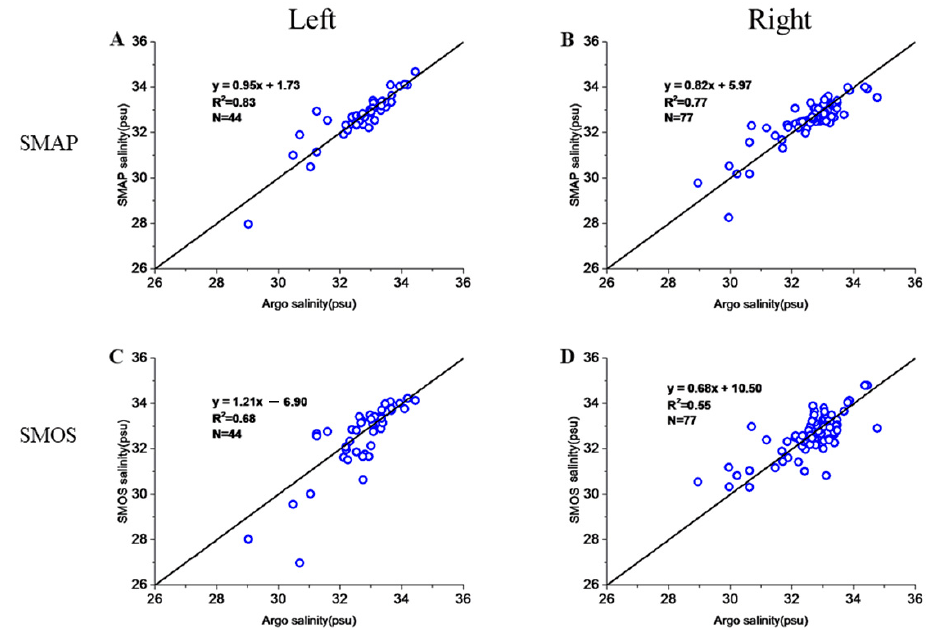
Figure 4. Scatter maps of S SMAP and S SMOS on left and right side of TC track after 10 TCs. Correlation after passage on ( A ) left side of TC track based on SMAP; ( B ) right side of TC track based on SMAP; ( C ) left side of TC track based on SMOS; ( D ) right side of TC track based on SMOS. Bao et al. compared the satellite SSS products (SMOS and SMAP) globally, and the